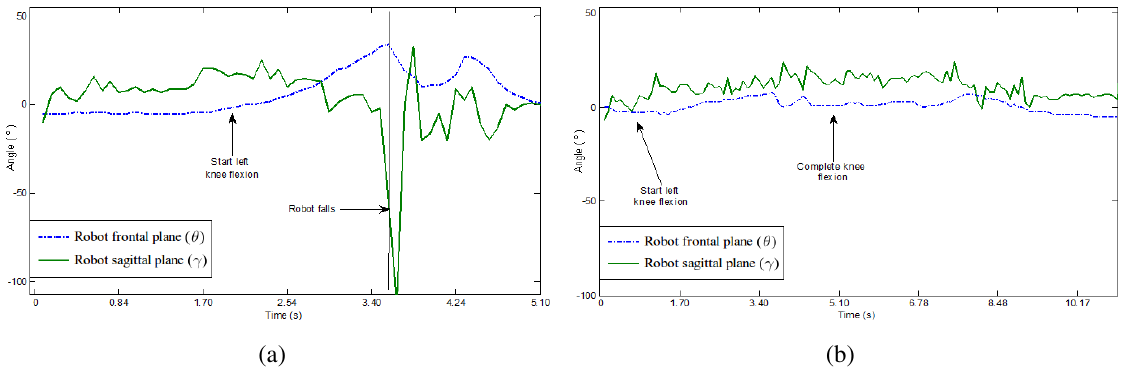
Figure 10. Left knee flexion exercise. ( a ) Human pose in left knee flexion and robot mirrored replication. ( b ) Compensated angles of the involved servomotors in the left knee